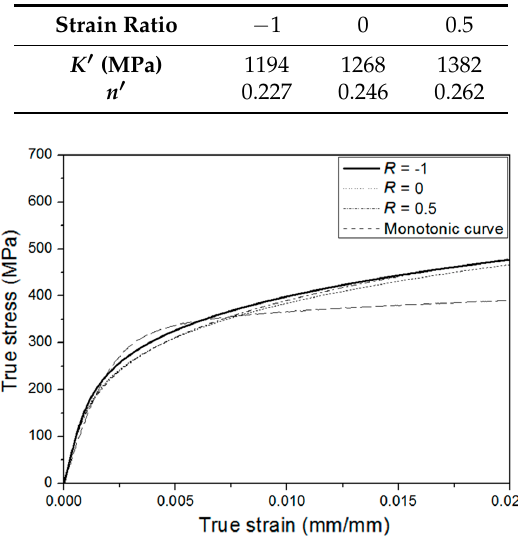
Figure 7. Cyclic stress–strain curve based on Ramberg–Osgood equation.